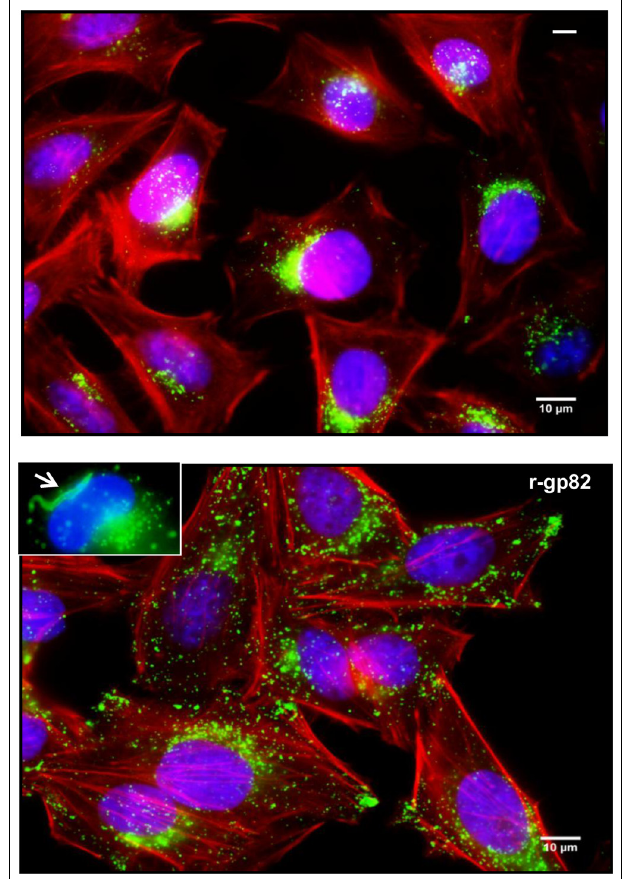
FIGURE 2 | Lysosome mobilization induced by MT gp82. Shown are HeLa cells incubated for 1 h in absence or in the presence of the recombinant protein (r-gp82) containing the complete gp82 sequence. Spread of lysosomes (green) from the perinuclear region to the cell periphery is induced by r-gp82. In the inset, recently internalized MT (arrow) inside the parasitophorous vacuole with lysosome marker is